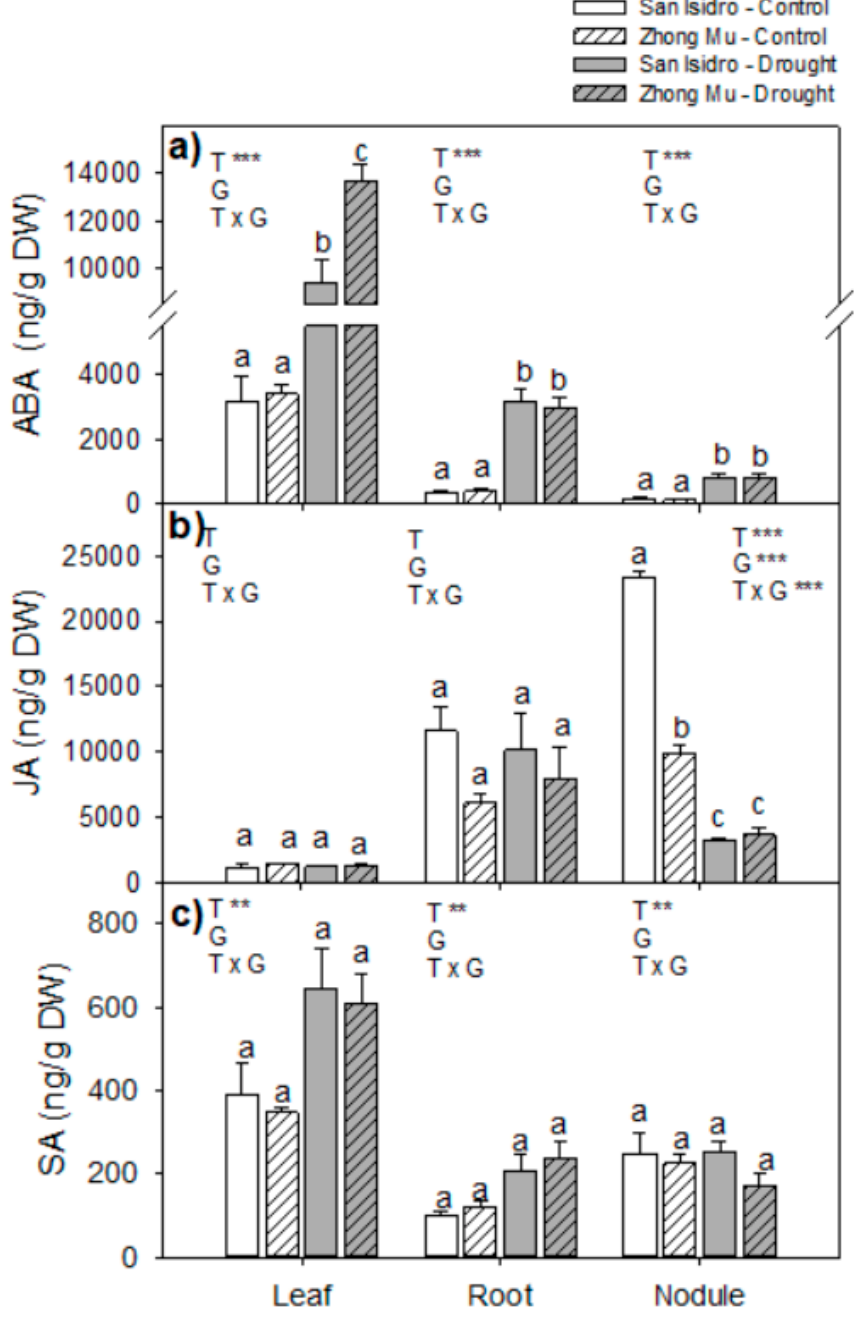
Figure 4. Stresses related hormones: ( a ) Abscisic acid (ABA); ( b ) jasmonic acid (JA) and ( c ) Figure salicylic acid (SA) content in leaves, roots and nodules under control and drought condition in two cultivars of Medicago sativa : San Isidro and Zhong Mu. Each value represents the mean ± SE ( n = 6). The different letters indicate significant differences ( p < 0.05). Asterisks indicate significant differences: * p < 0.05, ** p < 0.01, *** p < 0.001, in the two-way ANOVA for